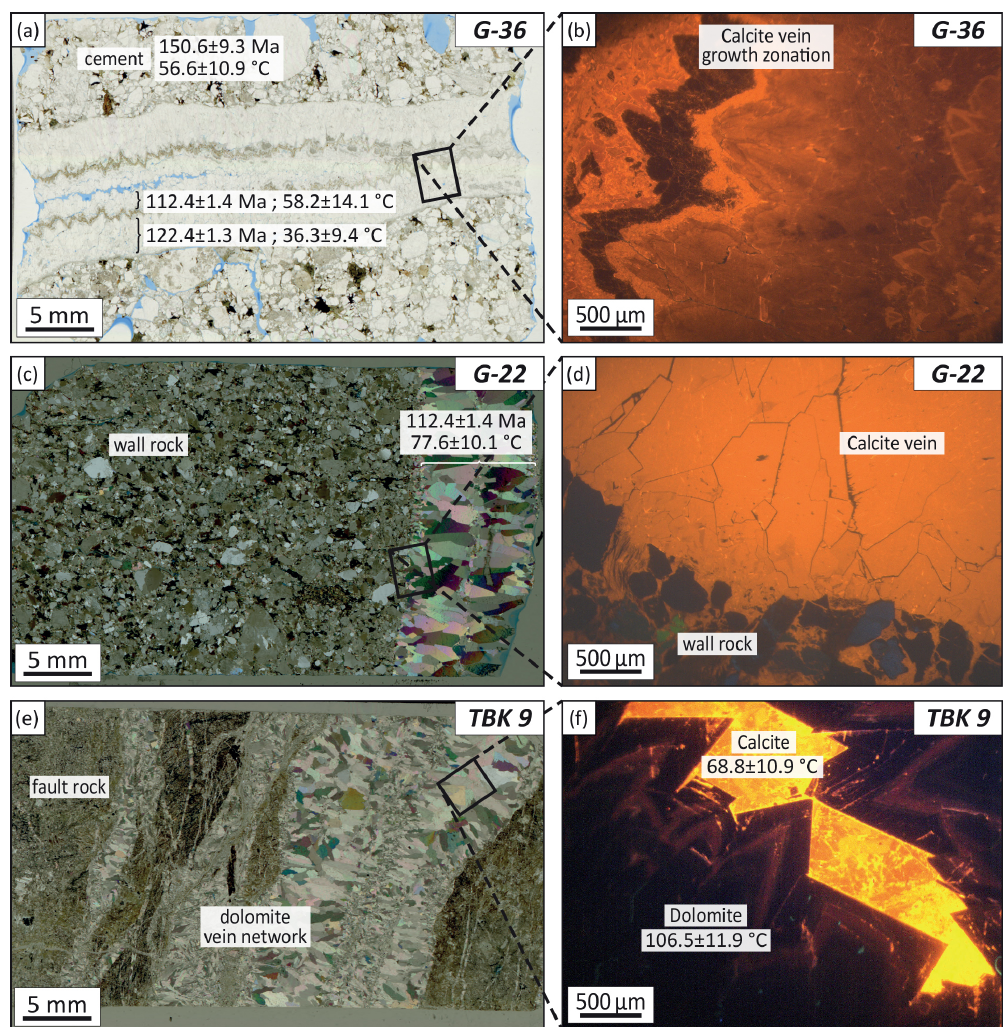
Figure 7. Thin section photos of hanging wall veins (a–d) and fault core veins (e, f) . The sample ID is given in the upper right corner of the respective image. Formation ages and temperatures given in figures where available (cf. Tables 1, 2). (a) Vein showing growth zonation; note ∼ 10Myr age difference between outer and inner growth generation (plane-polarized light); (b) cathodoluminescence (CL) close-up image of growth zonation; (c) vein devoid of growth zoning (cross-polarized light; XPL); (d) CL close-up image of calcite vein and calcite-cemented wall rock; (e) dolomite vein network cutting through cataclasite of Dombjerg Fault core (XPL); (f) CL close-up image of dolomite crystals; remaining cavities have been filled with younger